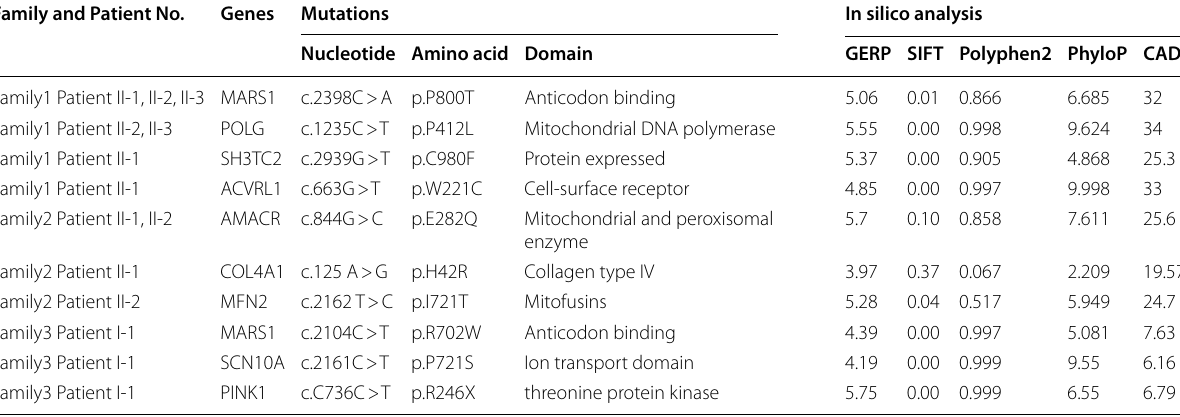
Table 3 All variants detected in our ion channel gene panel from 7 cases with FTN Family and Patient